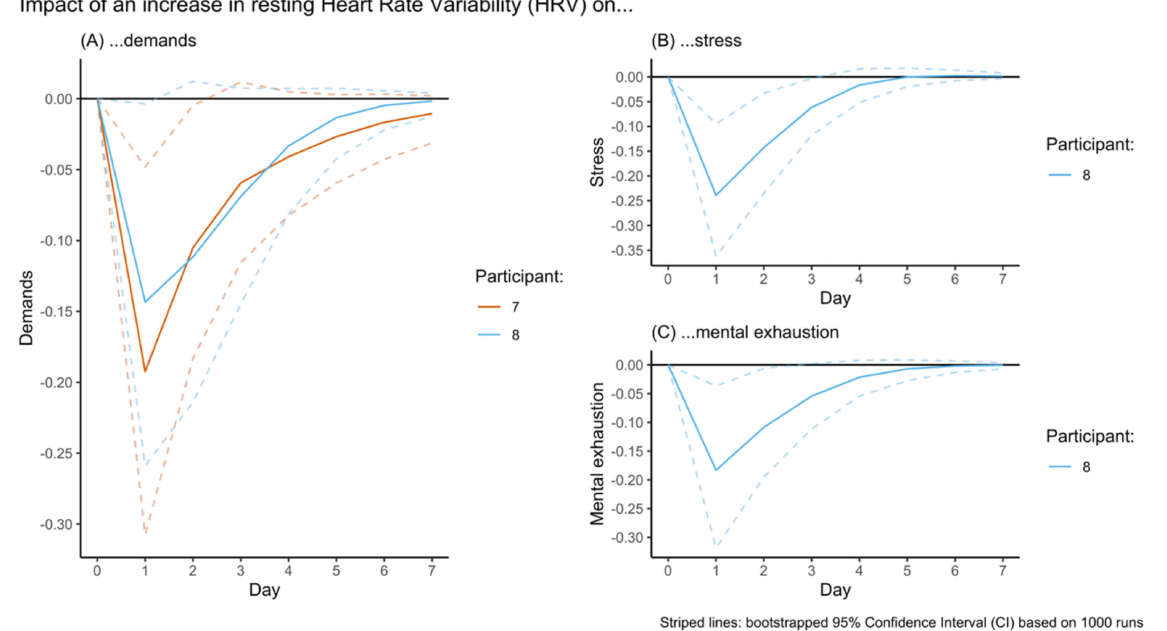
Figure 3. Visualization of the Impulse Response Function (IRF) of the impact of an increase in resting Heart Rate Variability (HRV) on the subsequent week’s demands, stress, and mental